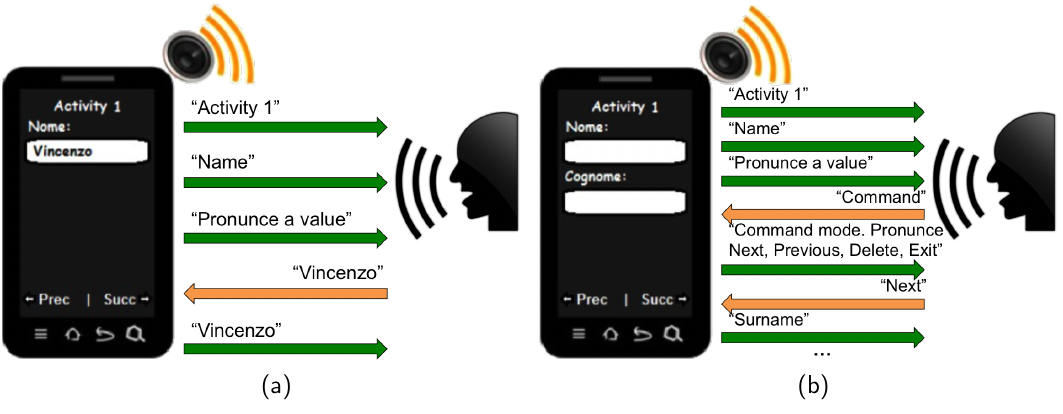
Figure 3. The Event ( a ) and Command ( b ) interactions between the user and the